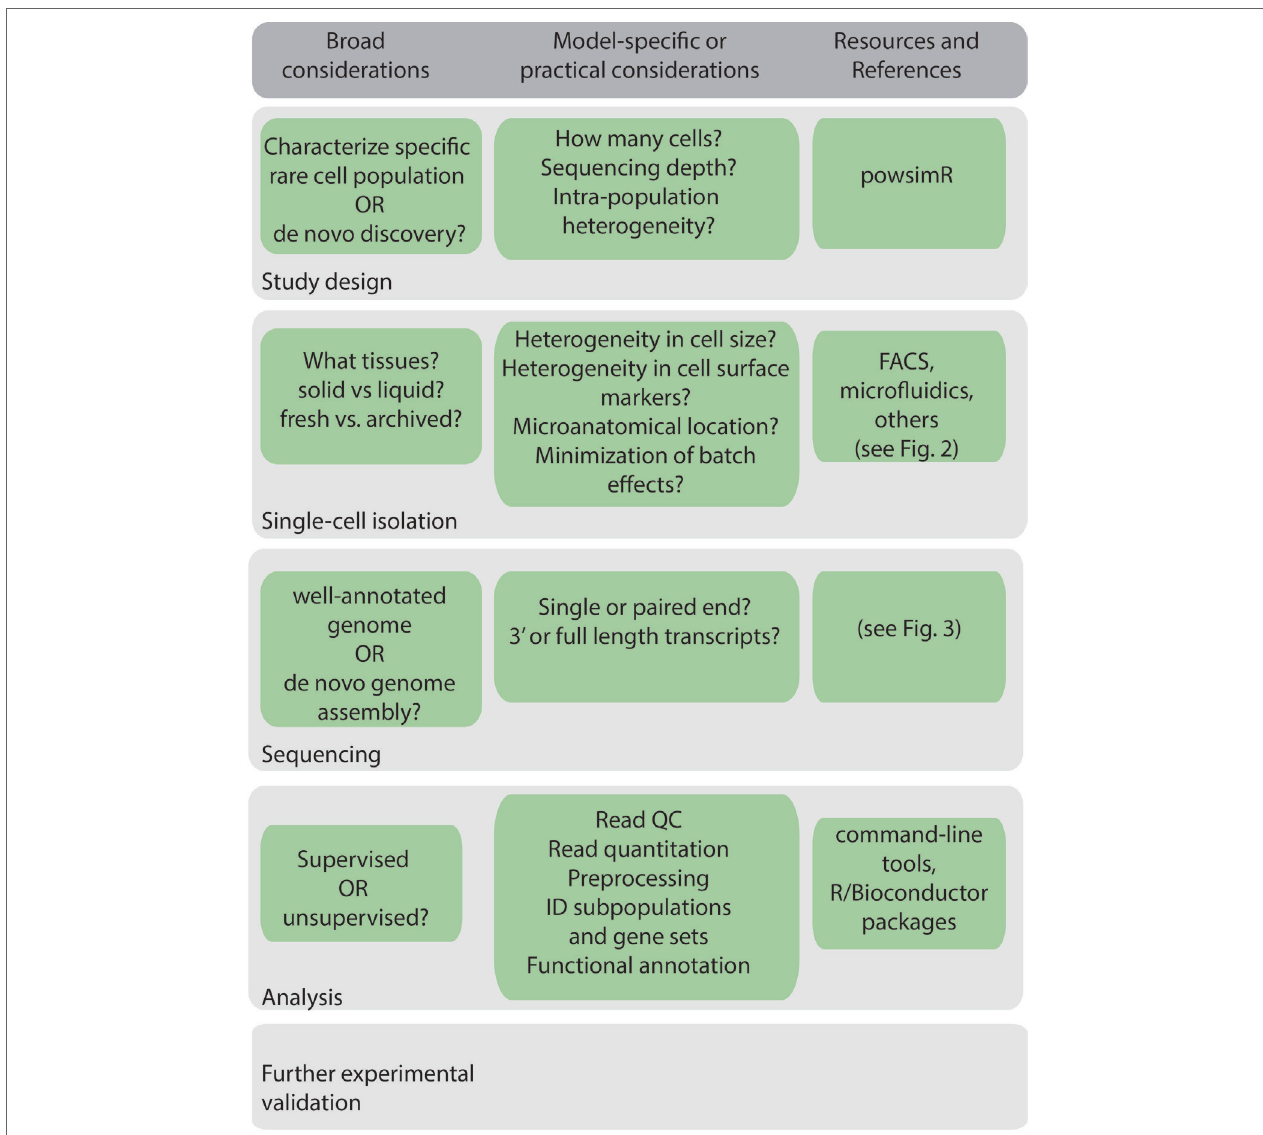
FigURe 1 | Key considerations in a general single-cell RNA sequencing